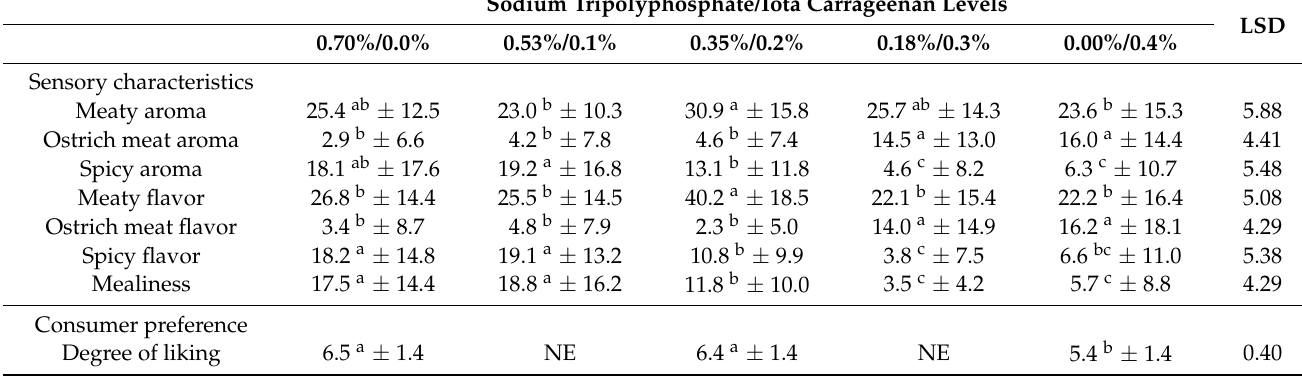
Table 4. Means ( ± SD) for the sensory characteristics and hedonic scores ( ± SE) of five ostrich hams manufactured with decreasing Sodium tripolyphosphate levels (n = 4 per